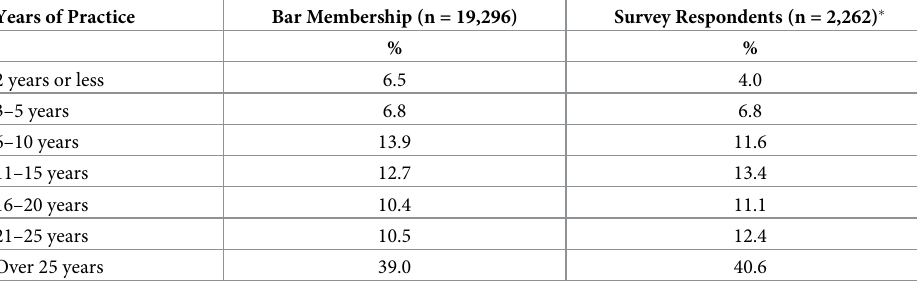
Table 1. Years of practice comparing general bar membership to survey